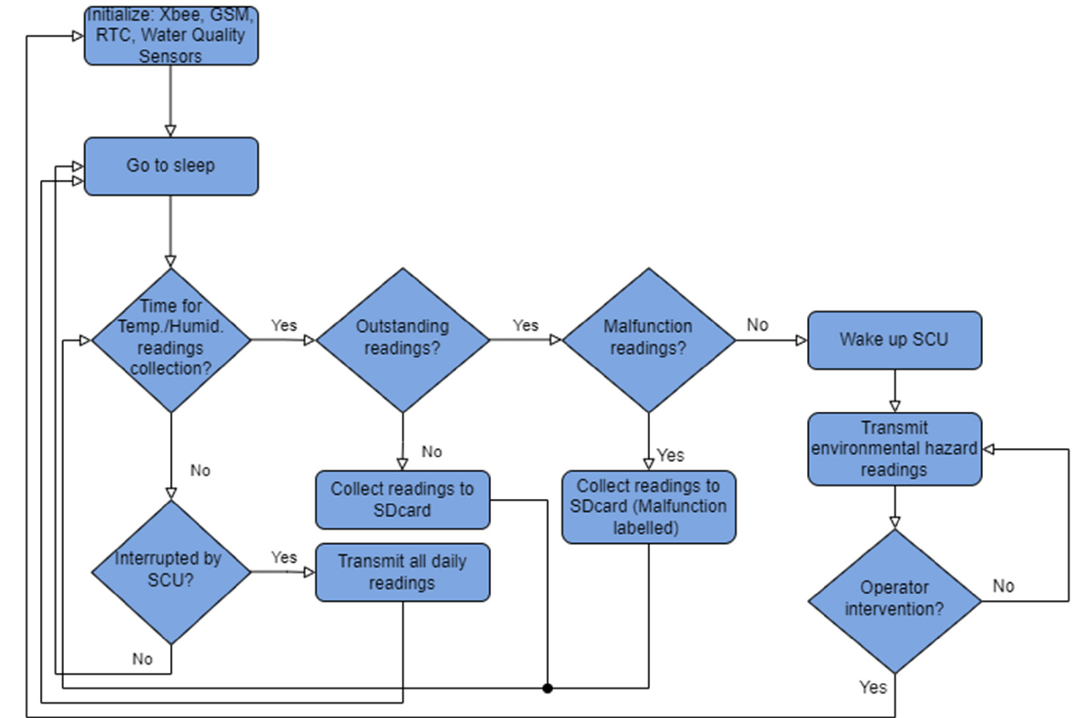
Figure 7. ESN flowchart.